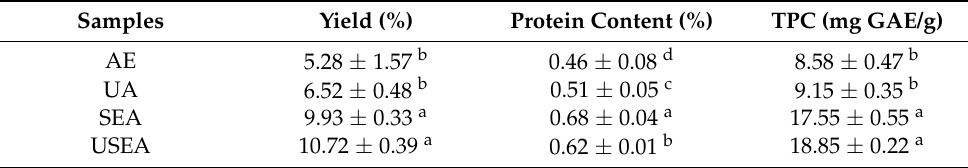
Table 1. Extraction yield, protein content and polyphenol content of pectin. Samples